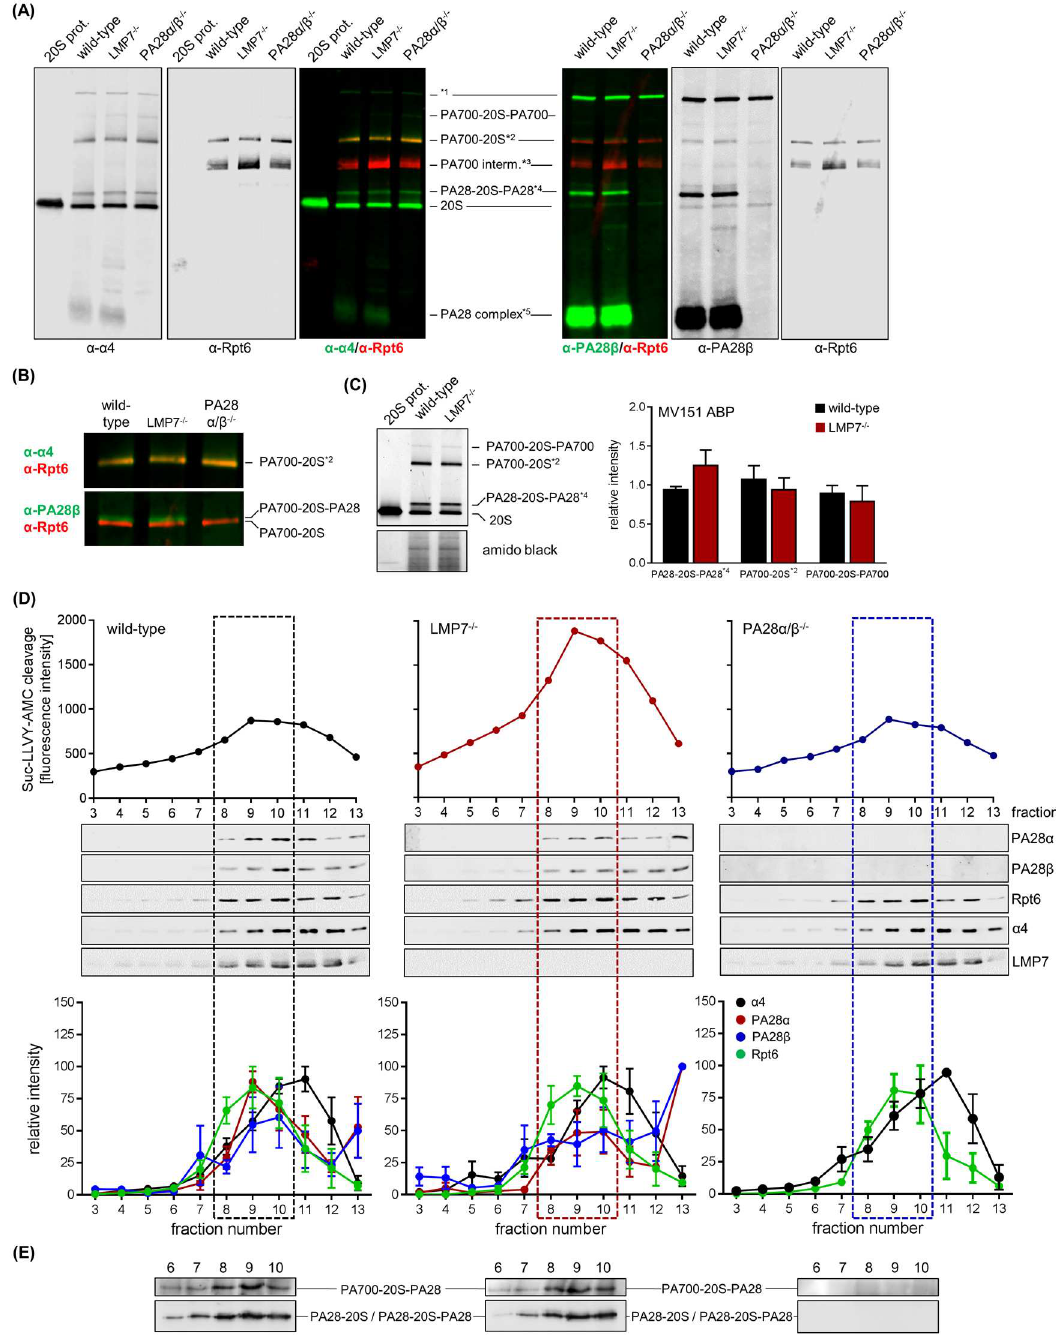
Fig 5. Characterization of PA28-proteasome complexes in wild-type and LMP7 − / − macrophages. (A) Cellular extracts were generatedfrom wild-type,LMP7 − / − and PA28 α / β − / − BMMs. Proteins were separated by native PAGE and subjectedto Western blotting of proteasome core ( α - α 4)and PA28 complex ( α -PA28 β ) co-stainedfor PA700 complex ( α - Rpt6), respectively.20S proteasome purifiedfrom mouse B8 fibroblasts was appliedfor comparison. Fluorescence dye- coupledsecondary antibodies were used for detection. * 1 –unspecific signal, * 2 –PA700-20S and PA700-20S-PA28, * 3 – PA700 intermediatecomplex[51], 4 * –PA200-20S-PA200 [52], 5 * –PA28 α / β not bound to a proteasome core. (B) Magnifiedsection of the α - α 4/ α -Rpt6 and α -PA28 β / α -Rpt6 double-staining from (A) depictingthe high molecularmass proteasome complexesPA700-20Sand PA700-20S-PA28. (C) Expression and accessibility of catalytically active proteasome subunitswithin different proteasome-proteasome regulatorcomplexeswas investigatedwith MV151 pan-